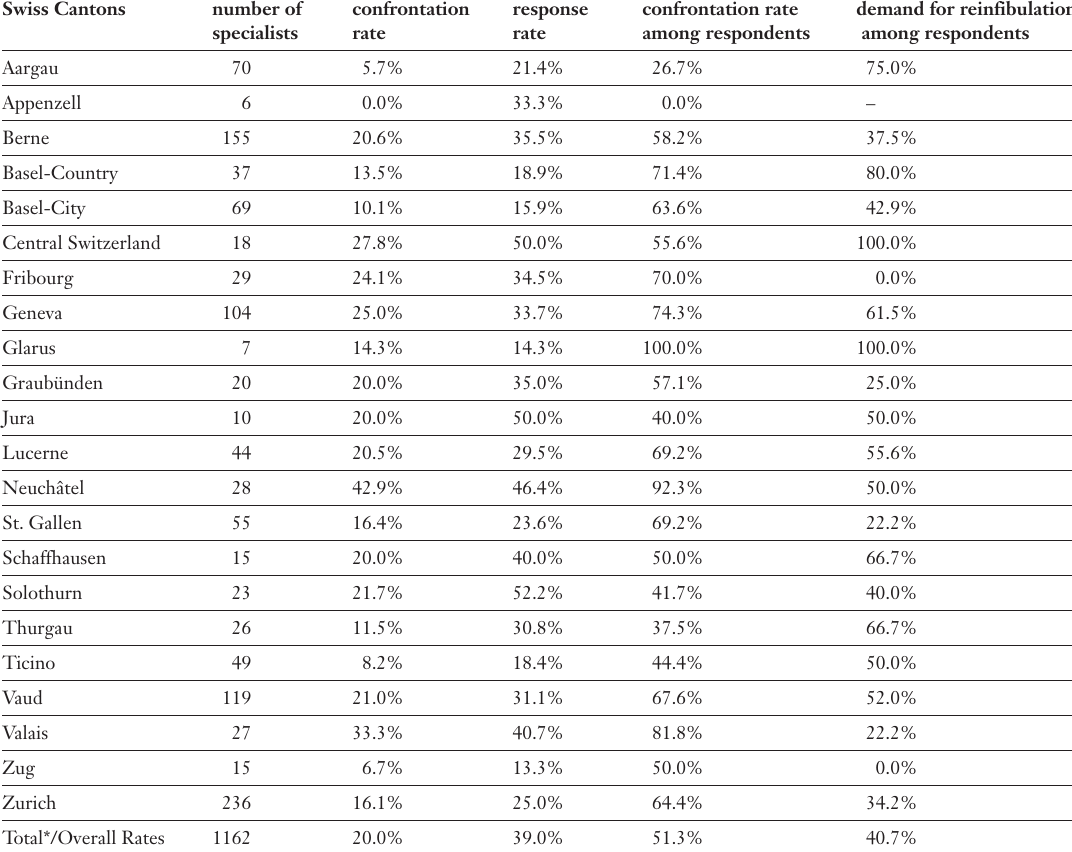
Confrontation rates for FGM among Swiss Gynaecolo- gists (*total number includes 114 anony- mous